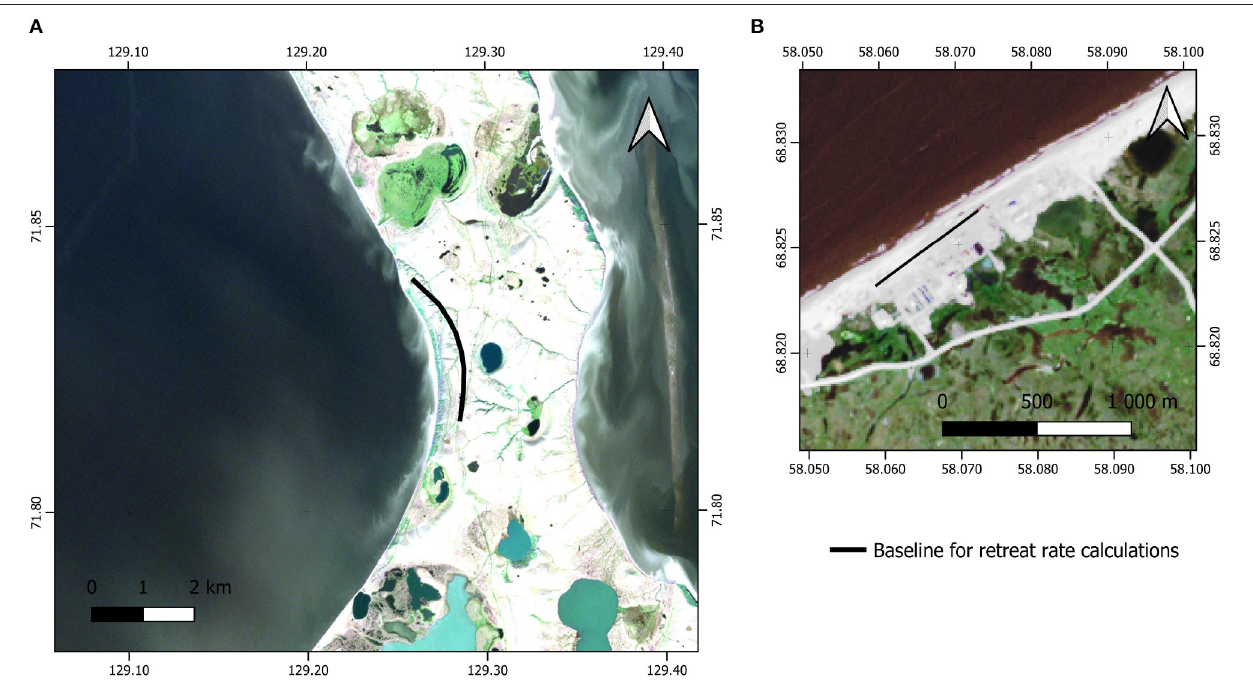
FIGURE 3 | Russian study sites: (A) West coast of the Bykovsky Peninsula, (B) Varandai, Barents Sea Coast. The baseline for rate calculations in this paper is shown in addition. Background: RGB (band 4, 3, and 2) composite of Sentinel-2 (optical, multi-spectral), Aug 28 2018 and Aug 8 2019.